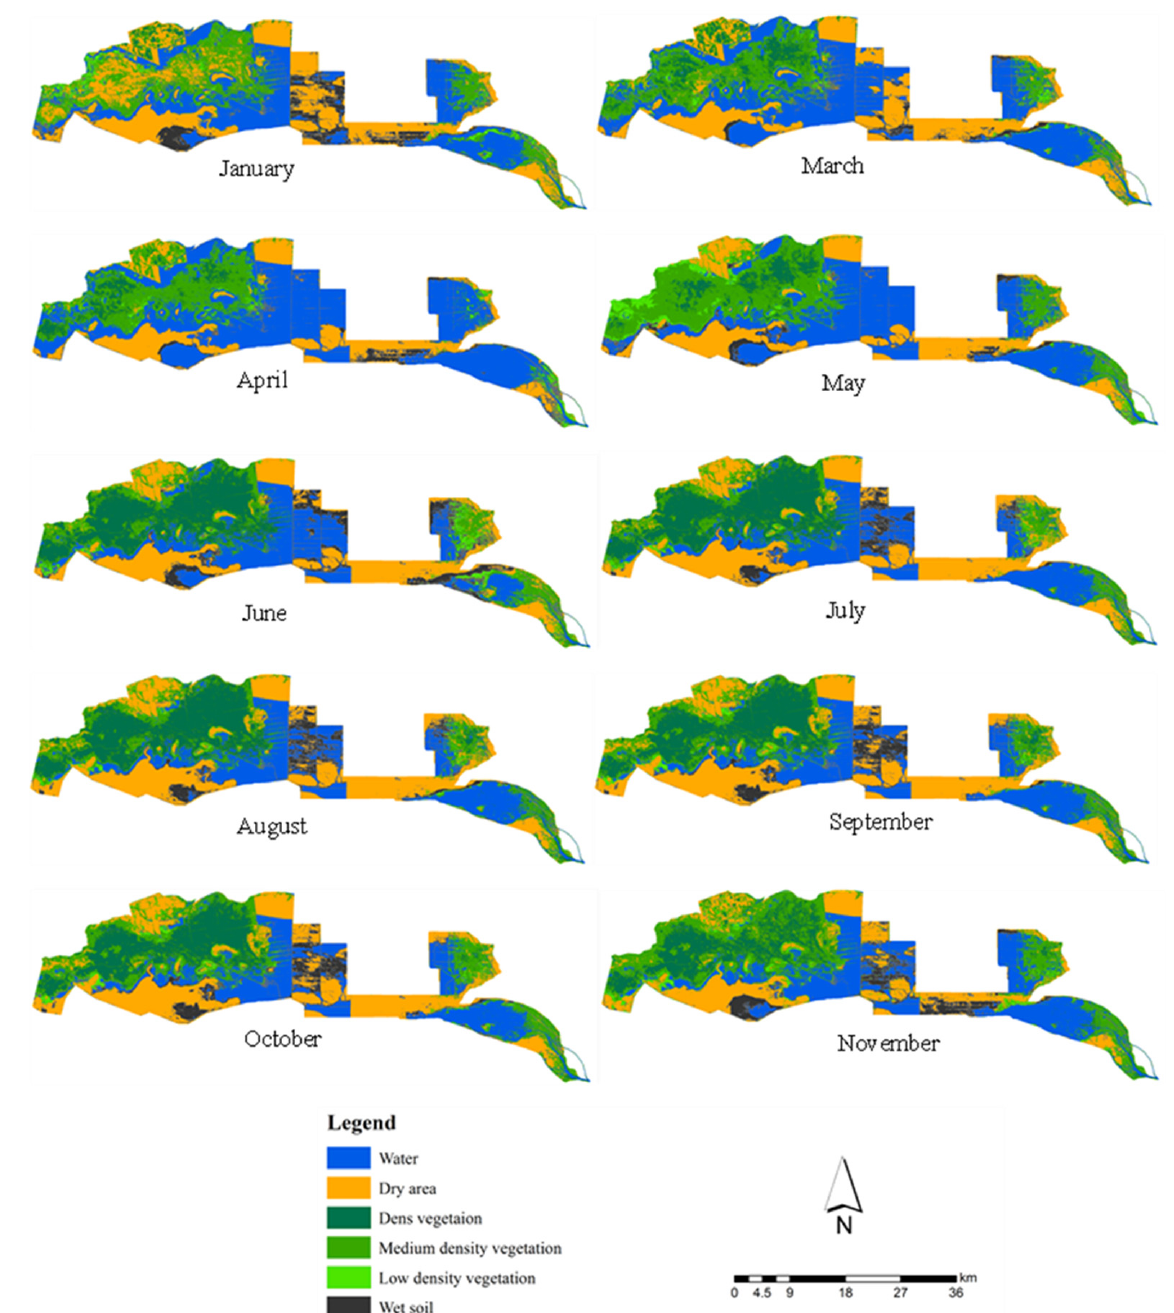
Figure 8. The extent of the marshland after the restoration